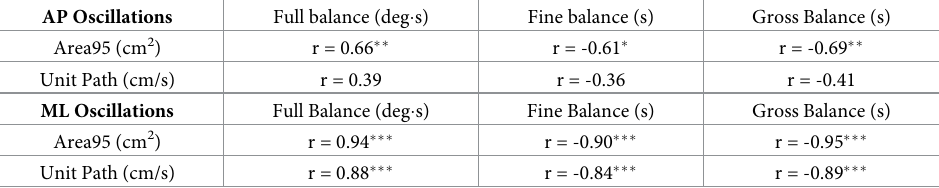
Table 4. Pearson correlations between CoP-related parameters (Area95 and Unit path) derived from the force platform and kinematic parameters (Full balance, Fine balance, and Gross balance) obtained from the instru- mented balance board.